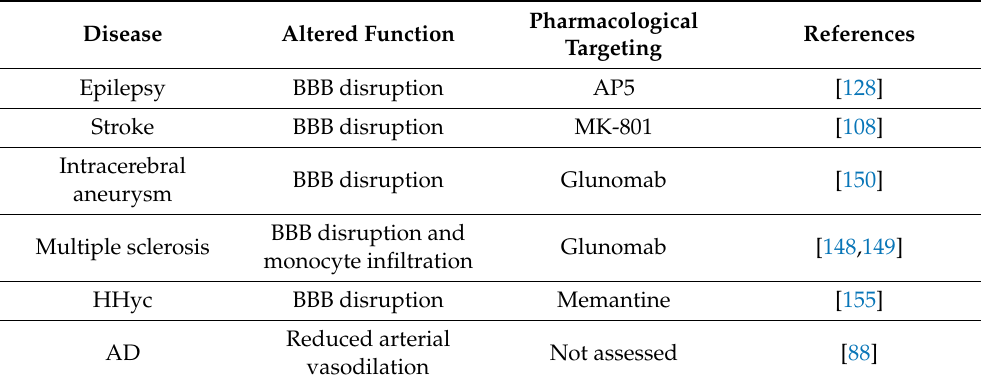
Table 4. The involvement of endothelial NMDARs in cerebrovascular disorders. Disease Altered Function